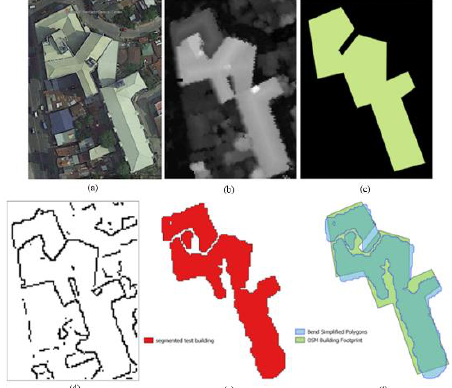
Figure 10. Daniel O. Mercado Medical Center. (a) aerial view taken from Google Earth, (b) LiDAR nDSM, (c) building footprint, (d) edge detection from LiDAR nDSM, (e)